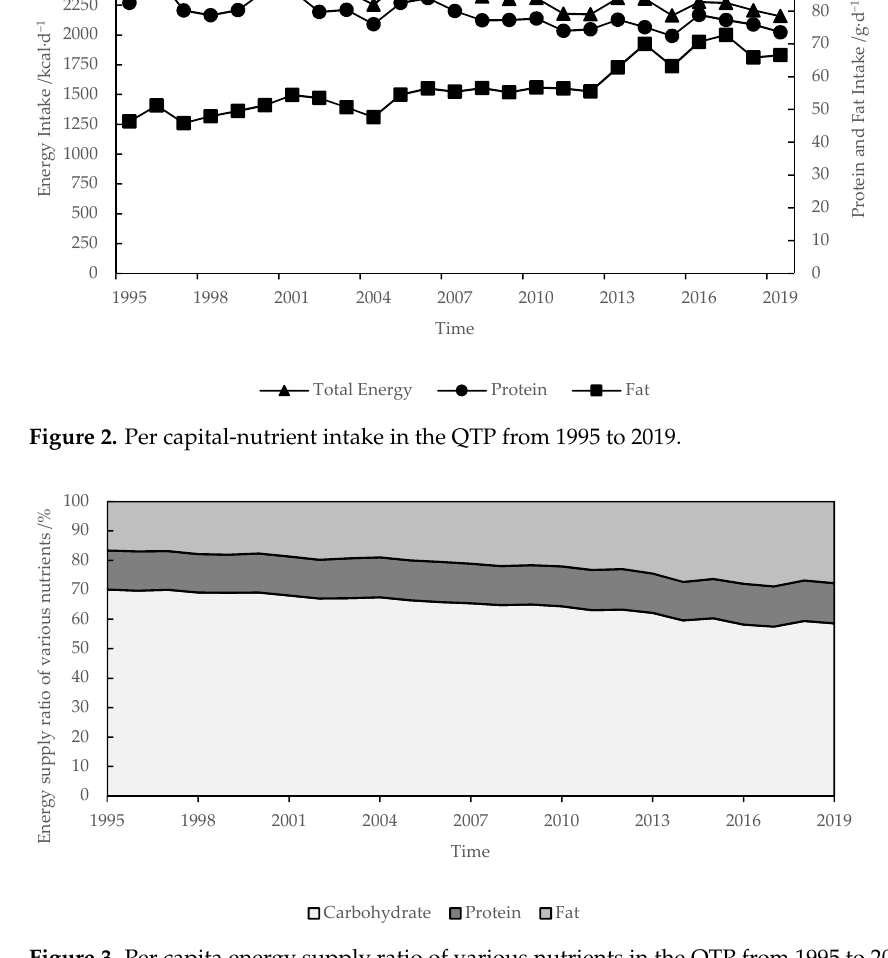
Figure 3. Per capita energy supply ratio of various nutrients in the QTP from 1995 to 2019.